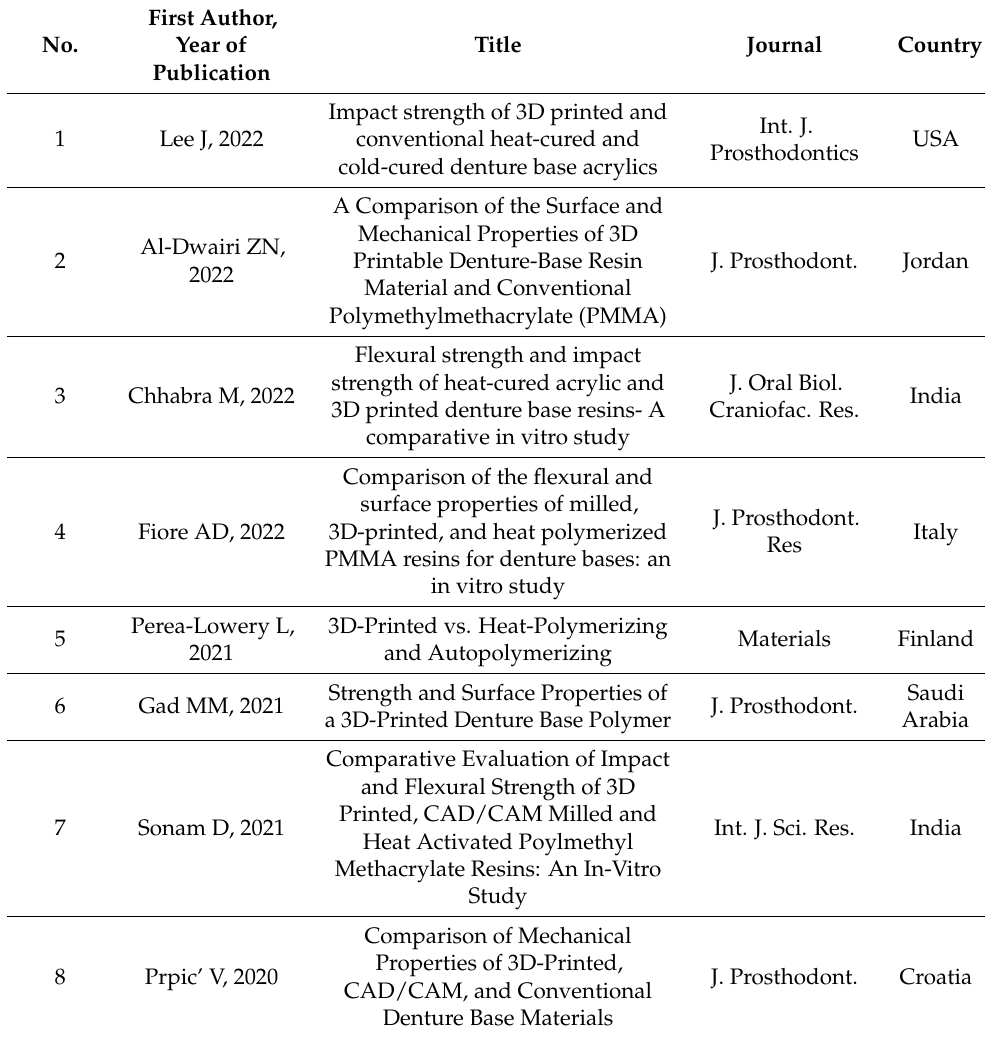
Table 1. Identification of studies included in the